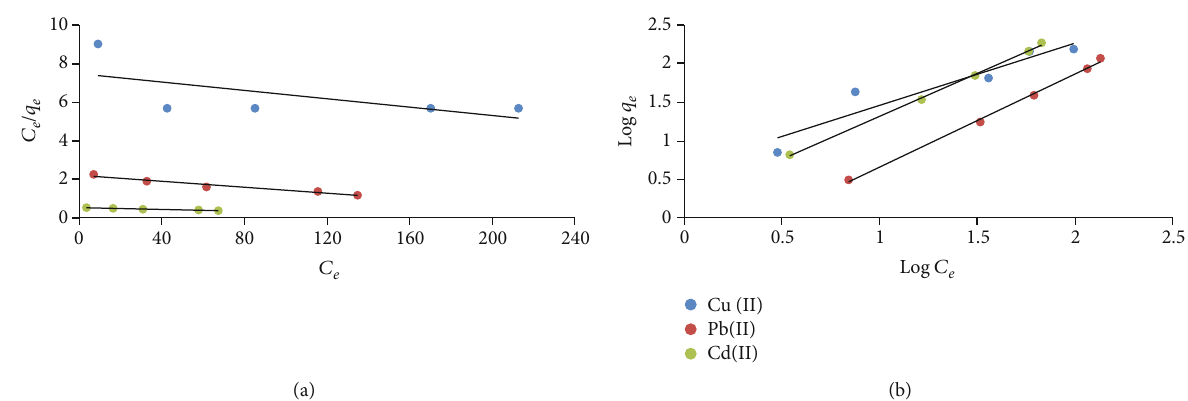
Figure 7: Adsorption isotherm of heavy metal ions on the prepared WPE/PAMK-TFN nanocomposite membrane (a) linear Langmuir and (b) linear Freundlich. Table 3: Adsorption isotherm parameters of heavy metal ions on the prepared WPE/PAMK-TFN nanocomposite membrane. Isotherm model